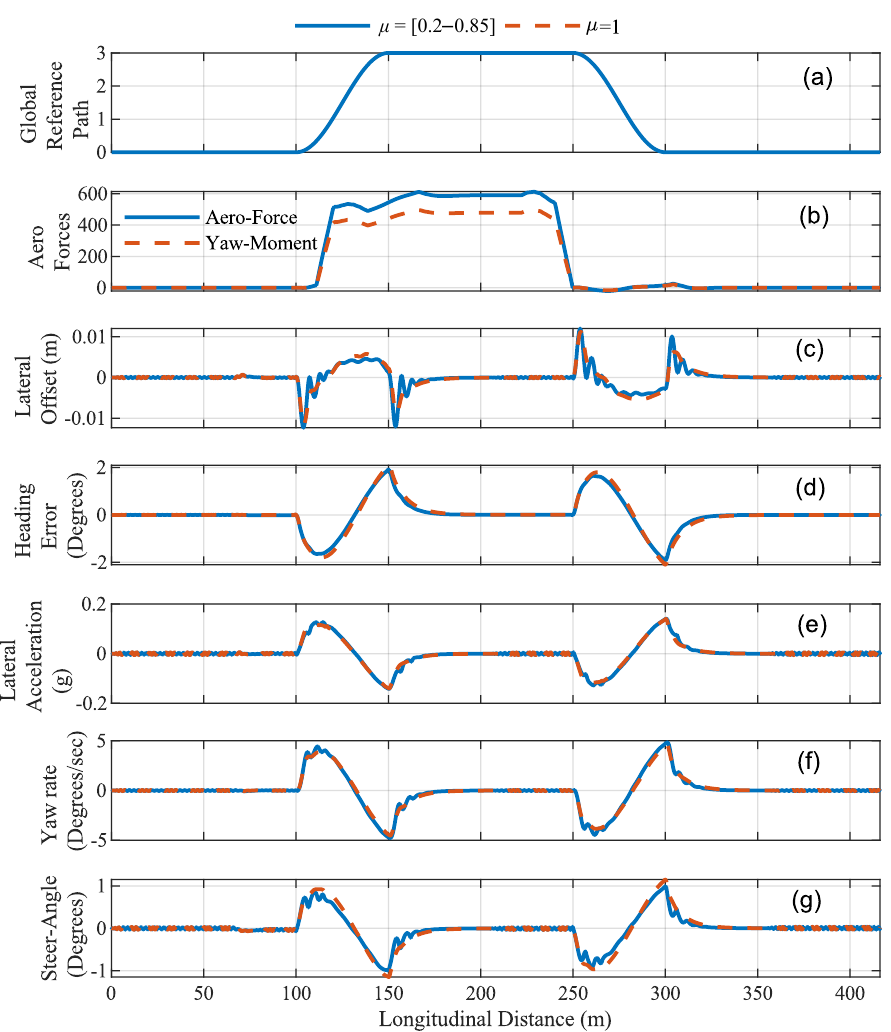
Figure 13. Lane keeping and vehicle stability performance of the proposed RBFNN-HOSM controller for v x = 60 km/h in the presence of disturbances and a variety of road conditions, µ ∈ [ 0.2–0.85 ] and µ = 1. ( a ) Global Reference Path, ( b ) Aero forces, ( c ) Lateral Offset, ( d ) Heading Error, ( e ) Lateral Acceleration, ( f ) Yaw Rate, ( g ) Road Steer Angle for various road